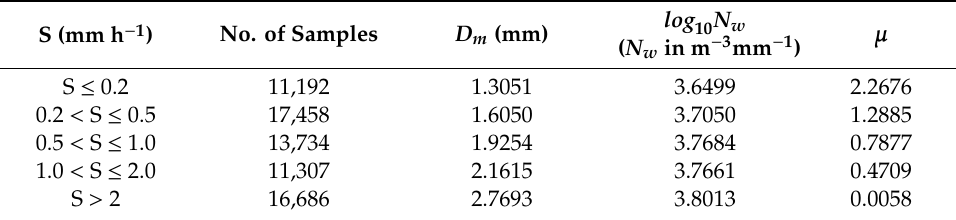
Table 4. Mean values of D m , log 10 N w , and µ for di ff erent snow rate